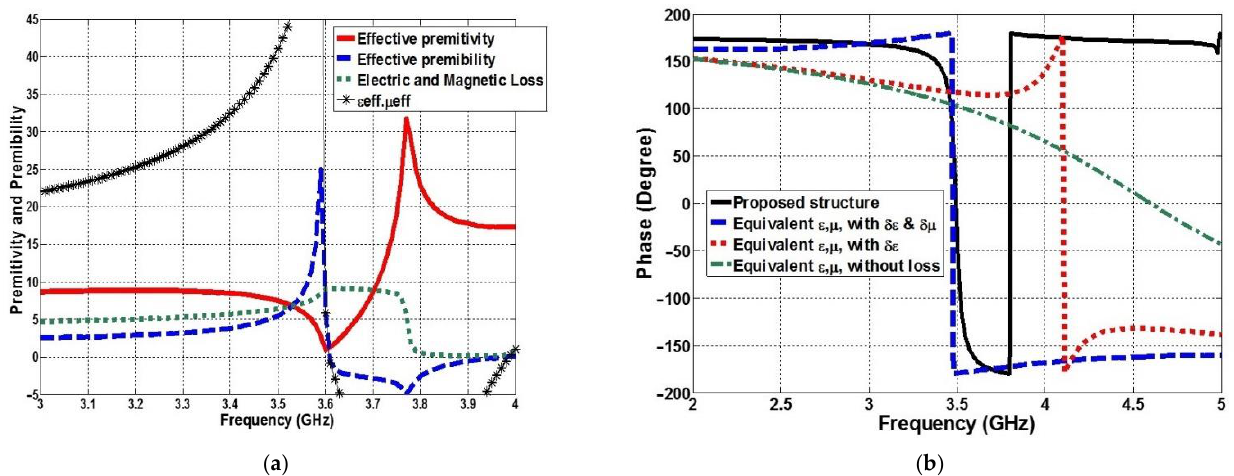
Figure 4. ( a ) Effective constitutive parameters of the proposed magneto dielectric substrate. The product of the effective permittivity and permeability is shown by star; ( b ) Reflection phase comparison between proposed substrate structure with other equivalent constitutive parameters.